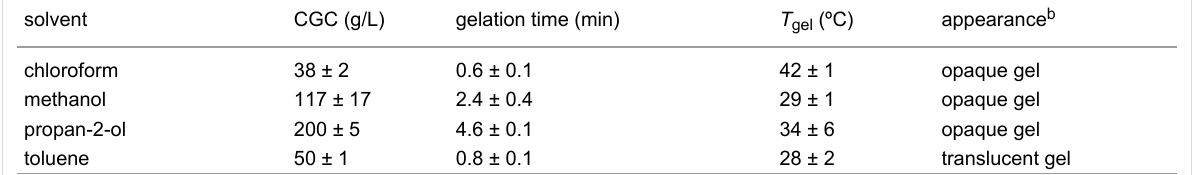
Table 2: Gelation ability, CGC, gelation time, T gel and appearance of gels made of squaramide diacid derivative 4 . a